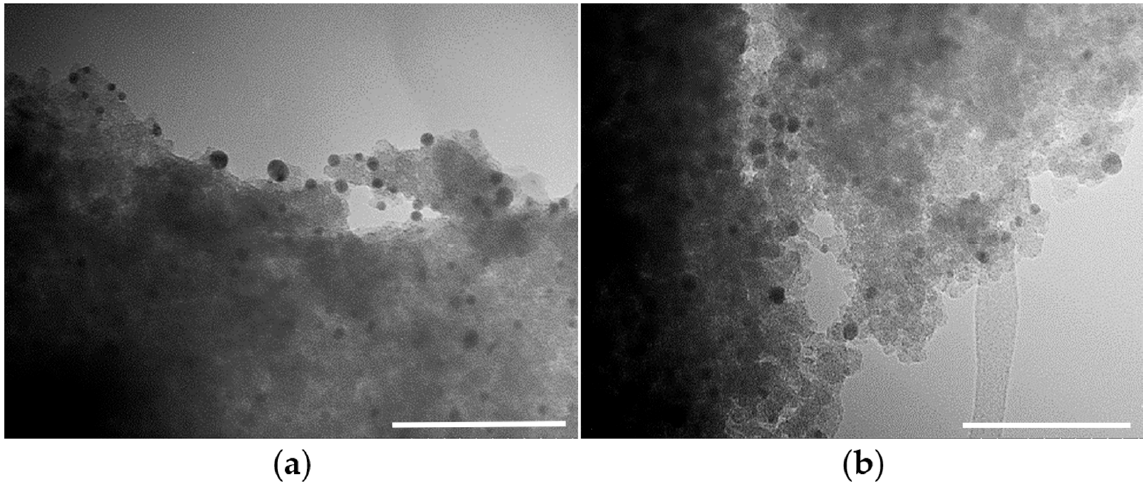
Figure 5. TEM micrographs of the ( a ) Au@meso-NH 2 -UiO-66-before-catalysis (scale bar is 100 nm) and ( b ) Au@meso-NH 2 -UiO-66-after-catalysis (scale bar is 200 nm) nanohybrids.